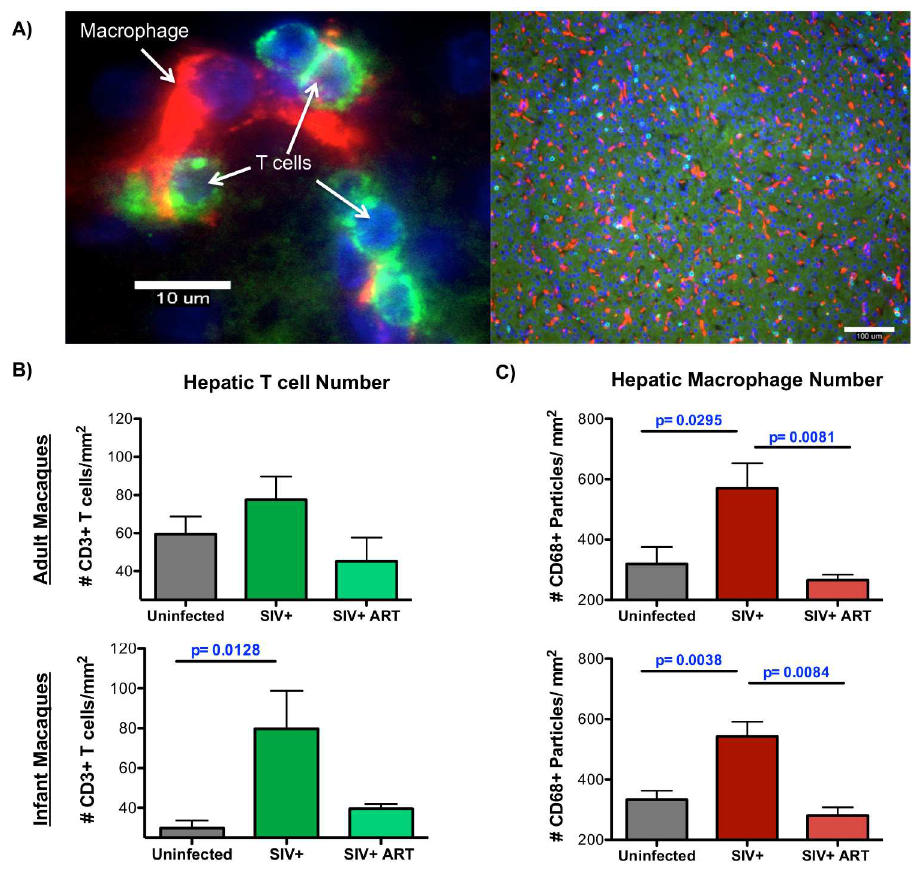
Fig 1. Increased number of macrophages and T cells observed in the liver during SIV infection. CD68 macrophages and CD3 T cells were enumerated in the liver of uninfected, chronically SIV-infected, and chronically SIV-infected, cART infant or adult rhesus macaques by immunofluorescence microscopy. A) Fluorescent images at 600x (left image, scale bar = 10 um) and 100x (right image, scale bar = 100 um) depicting specific staining for macrophages (red) and T cells (green) in the liver (blue indicates nuclei). For quantification, eight random fields in the liver were imaged under 100x magnification and then analyzed by ImageJ software. B) Quantification of eight random fields of view for each animal to enumerate CD3 T cells by ImageJ Cell Counter analysis with adult and infant macaques graphed separately (top and bottom panels, respectively). C) Quantification CD68 macrophages in eight random fields of view for each animal using ImageJ Particle analysis. Data are graphed as the mean ± SEM. Statistical significance between groups was determined Mann Whitney T tests.